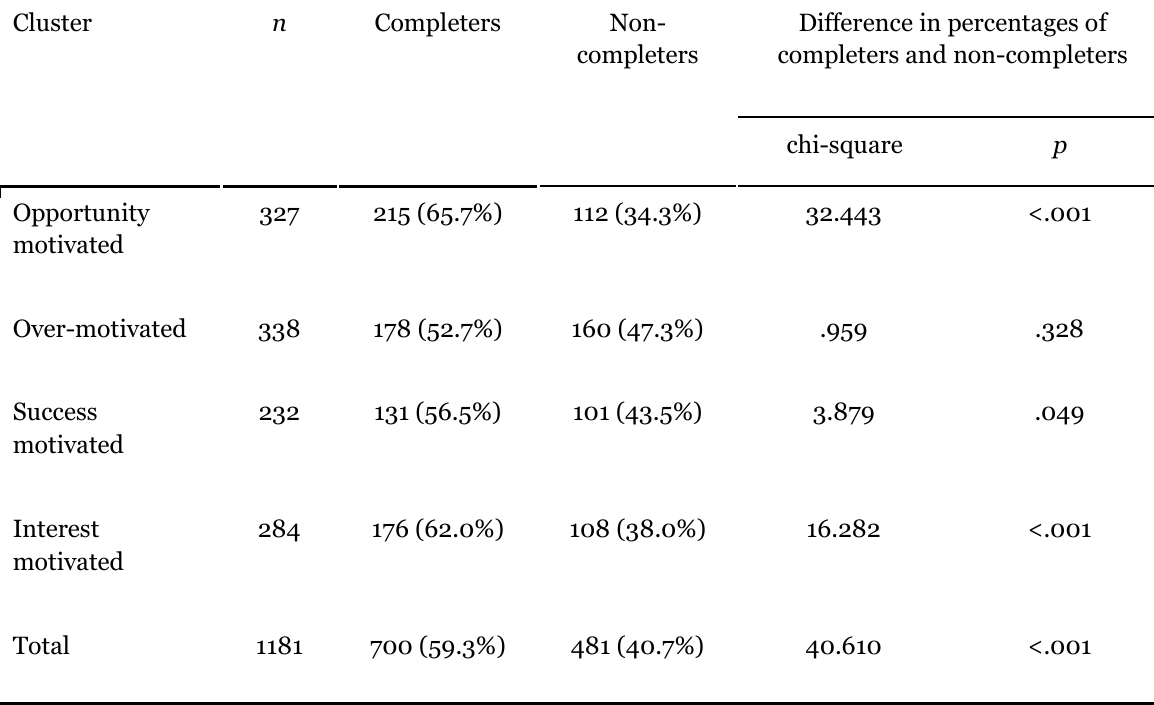
Comparison of Percentages of Completers and Non-Completers in the Clusters Cluster n Completers Non-